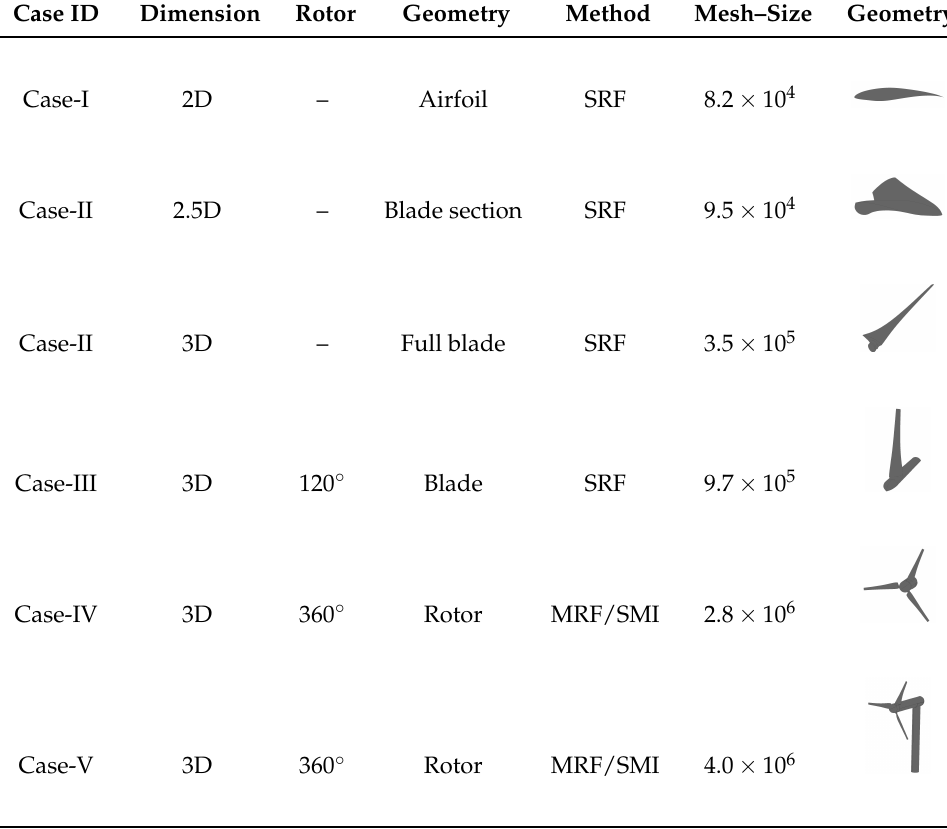
Figure 1. HAWT-S826: CAD model of the turbine along with description of the geometric parameters. Table 1 illustrates the domain and boundary conditions employed for each case. Herein, we provide an overview of the case description. Table 1. HAWT-S826: An overview of geometric approximations employed together with the numer- ical techniques. Six levels of geometric complexities are considered, i.e., a 2D airfoil (Case-I), 2.5D blade section, 3D full blade (Case-II), 120 ◦ blade (Case-III), 360 ◦ rotor (Case-IV), and complete turbine structure with a nacelle and tower (Case-V). The first two cases discuss flow around a stationary blade using SRF, while the rest is used to simulate flow around a rotating rotor with MRF and SMI. However, Case-III utilized periodic boundary conditions with SRF for the numerical